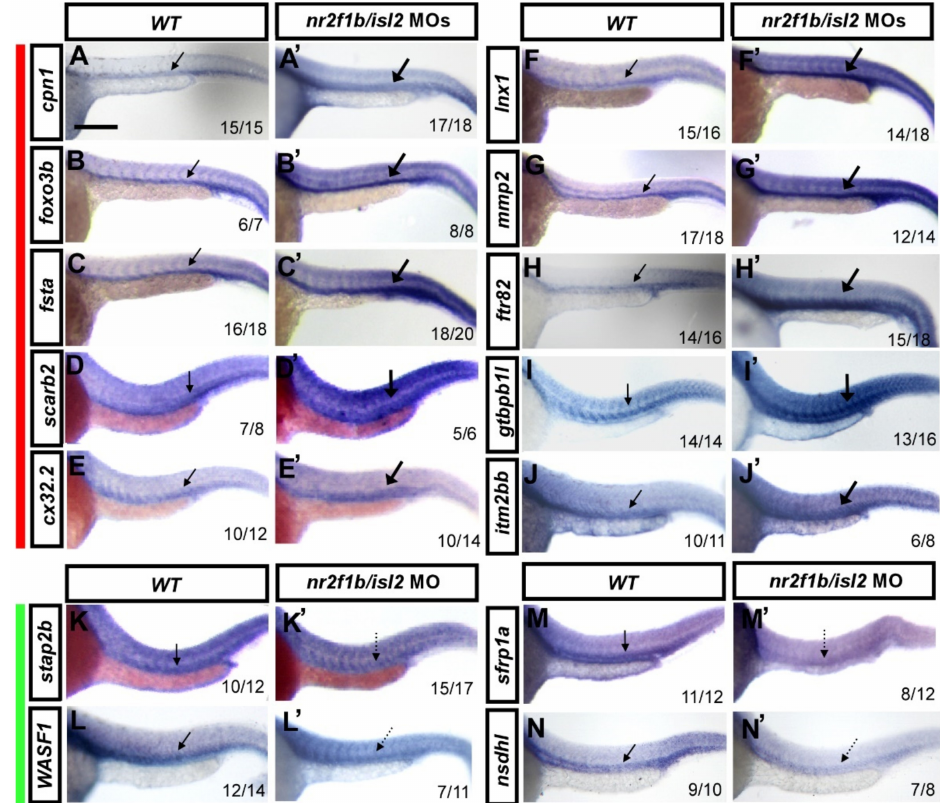
Figure 2. Verification of vascular-specific expression of potential targets in wt and double knockdown isl2/nr2f1b MOs by in situ hybridization. Embryos were injected with a combination of isl2 and nr2f1b morpholinos (8 and 1.7 ng each) and gene expression was examined by in situ hybridization at 24 h post-fertilization. Representative wt control embryos are on the left of each panel and isl2/nr2f1b morpholino (MO)-injected embryos are on the right. (( A – J , A (cid:48) – J (cid:48) ) red bar aside) The increased expression of ( A (cid:48) ) cpn1 , ( B (cid:48) ) foxo3b , ( C (cid:48) ) fsta , ( D (cid:48) ) scarb2 , ( E (cid:48) ) cx32.2 , ( F (cid:48) ) lnx1 , ( G (cid:48) ) mmp2 , ( H (cid:48) ) ftr82 , ( I (cid:48) ) gtpbp1l , and ( J (cid:48) ) itm2bb in the vasculature in isl2/nr2f1b morphants (thick arrows) compared to wild-type embryos ( A – J ). ( K – N , K (cid:48) – N (cid:48) green bar aside) The reduced expression of ( K (cid:48) ) stap2b , ( L (cid:48) ) WASF1 , ( M (cid:48) ) sfrp1a , and ( N (cid:48) ) nsdhl in the vessels in isl2/nr2f1b morphants (dash arrows) compared to wild-type embryos ( K – N ). These data consist of the transcriptome results. Values on the bottom indicate the number of embryos exhibiting a phenotype per the total number of embryos